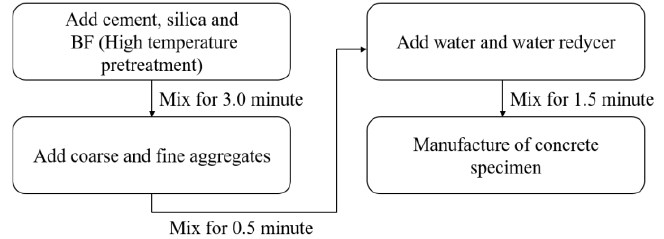
Figure 2. Mixing procedures of BFRAC.